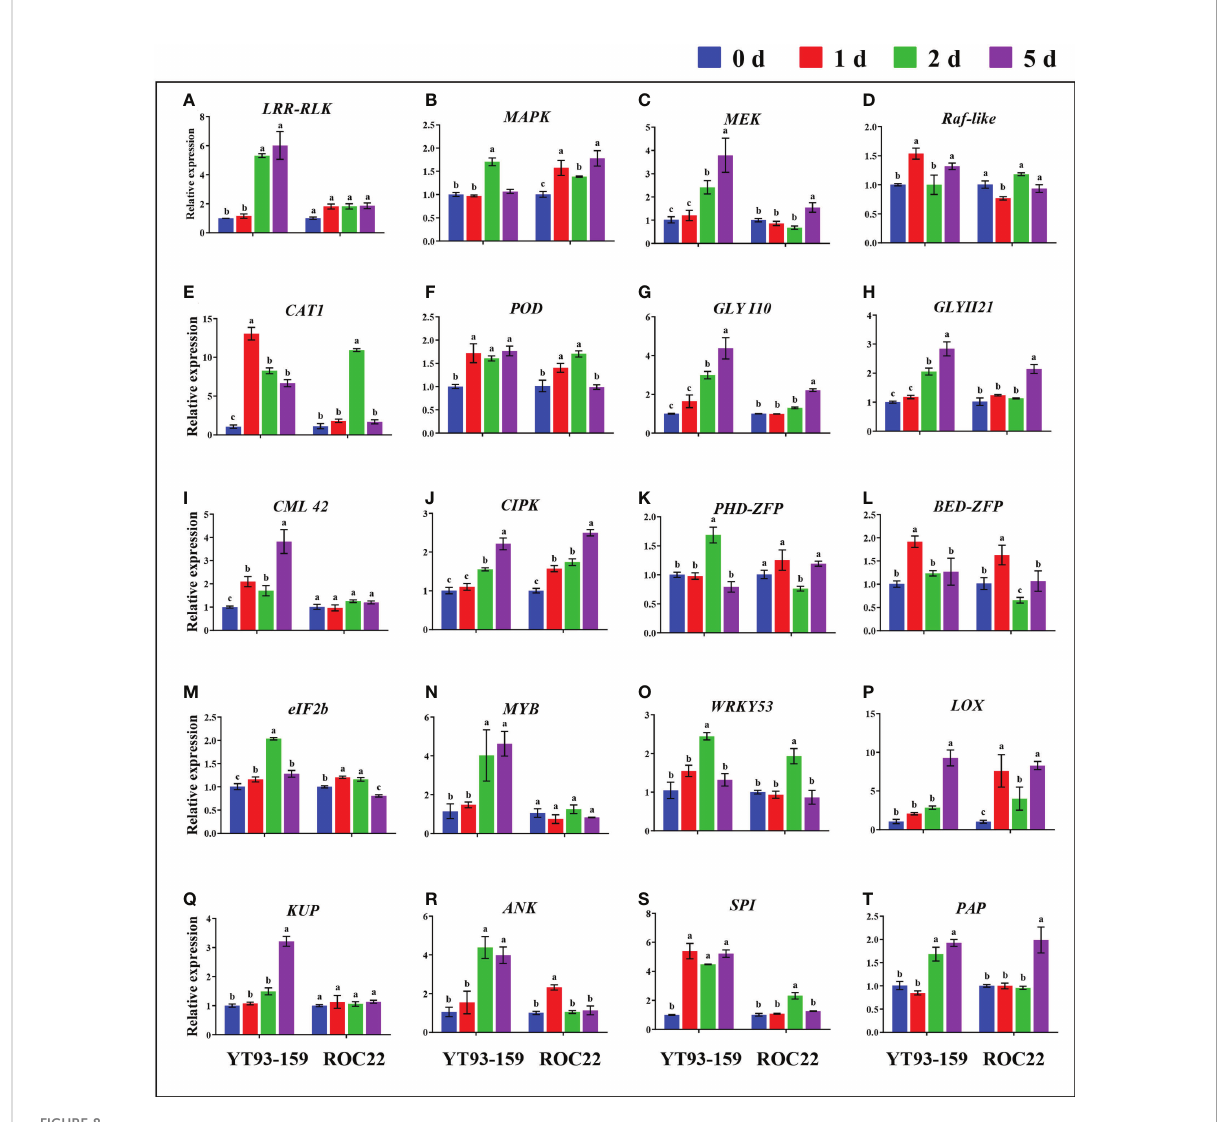
FIGURE 8 Comparative expression analysis of 20 key genes between YT93-159 and ROC22 at 0 d (blue), 1 d (red), 2 d (green), and 5 d (purple) post S. scitamineum -inoculation by RT-qPCR. Different letters indicate a signi fi cant difference at 5% level ( p ≤ 0.05). All data points are mean ± standard error ( n = 3). (A) LRR-RLK; (B) MAPK; (C) MEK; (D) Raf-like; (E) CAT1; (F) POD; (G) GLYI10; (H) GLYII21; (I) CML42; (J) CIPK; (K) PHD-ZFP; (L) BED-ZFP; (M) eIF2B; (N) MYB; (O) WRKY53; (P) LOX; (Q) KUP; (R) RNK; (S) SPI; (T)